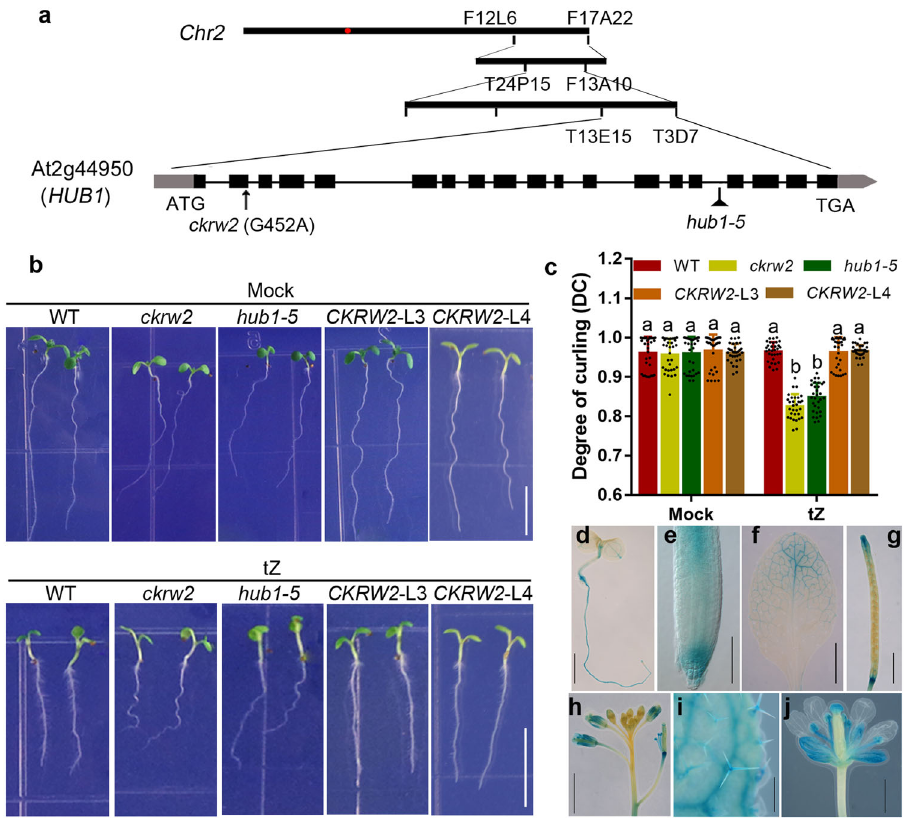
Fig. 2 Gene cloning and the expression pattern of CKRW2 gene. a Map-based cloning, showing the position of the G452A point mutation causing premature termination in the AT2G44950 gene coding region. b , c Similar phenotypes of ckrw2 and hub1-5 ( b ), and molecular complementation ( c ). Seedlings were grown on MS with or without 0.01 μ M tZ. Bars = 5 mm. Data are presented as mean ± SD ( n = 30 – 35), three independent experiments, the letters indicate a signi fi cant difference at P < 0.05, according to ANOVA followed by Tukey ’ s multiple comparison tests. d – j GUS activity was detected in various organs at different developmental stages of pCKRW2: GUS transgenic plant. 4-day-old seedlings ( d – g ) or 4-week-old plants ( h – j ). Scale bars = 5 mm in ( d ) and ( j ); 100 µ m in ( e ); 20 mm in ( f ) and ( h ); 10 mm in ( g ).